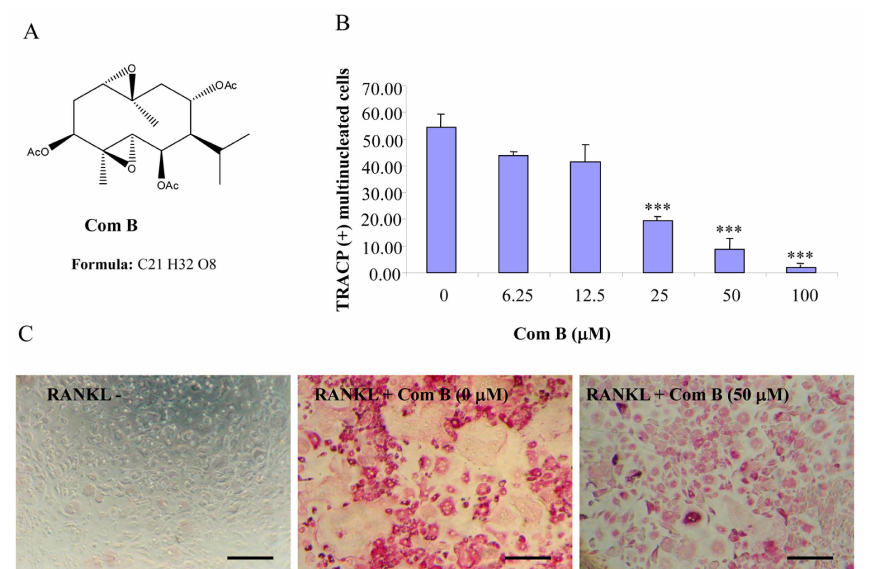
Figure 2. Compound B inhibits RANKL-induced osteoclastogenesis. ( A ) Chemical structure of compound B; ( B ) mouse BMMs cultured in a 96-well plate in the presence of RANKL (100 ng/mL) and M-CSF (10 ng/mL) with or without compound B for five days were fixed with 4% paraformaldehyde and stained for TRACP activity. Quantitative analysis shows the mean number of TRACP-positive multinucleated cells (MNC). (*** p < 0.001 compared to RANKL treated control, n = 3); and ( C ) representative light microscope images showing the effect of compound B on RANKL-induced osteoclast formation. (Mag = 20 ˆ , scale bar = 100 µ m).